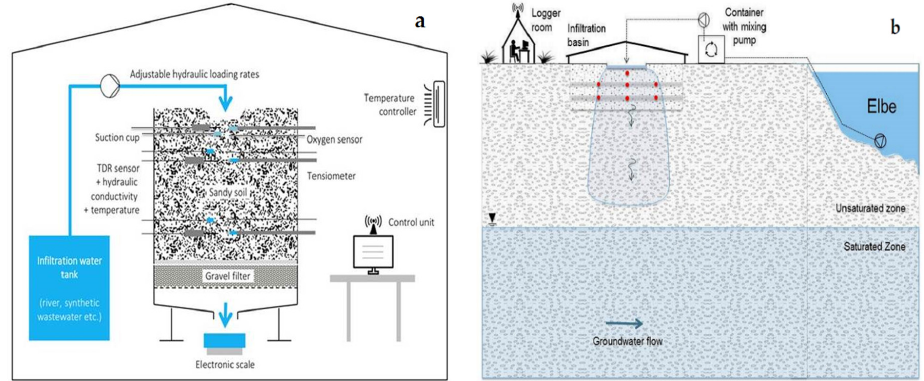
Figure 1. Experimental set-up of infiltration laboratory scale unit ( a ) and infiltration field scale unit ( b ).